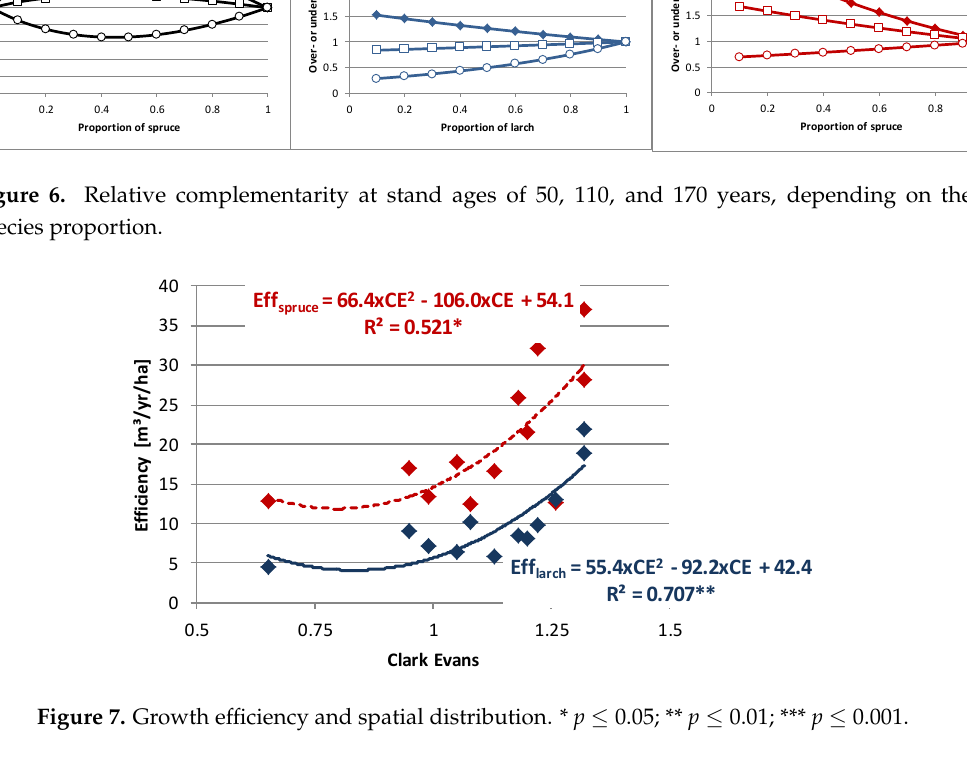
Figure 7. Growth efficiency and spatial distribution. * p ≤ 0.05; ** p ≤ 0.01; *** p ≤ 0.001.